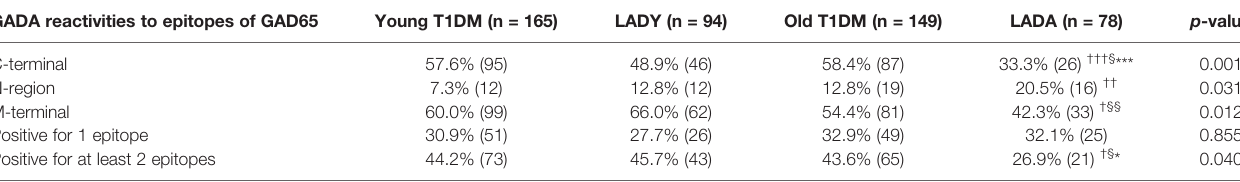
TABLE 1 | Prevalence of epitope-speci fi c GAD65Ab in young T1DM, old T1DM, LADY, and LADA patients.